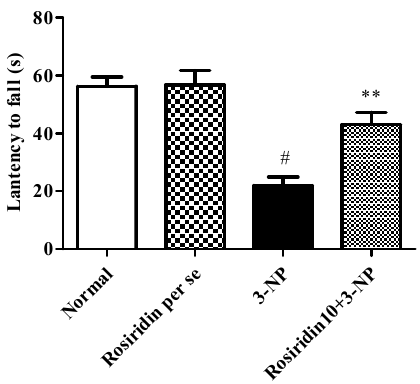
Figure 3. Effect of rosiridin on the hanging-wire test. Values are expressed as the mean ± SEM (n = 6). Values are statistically significant at p < 0.05 (one-way ANOVA followed by Dunnett’s test). Express the data ( # p < 0.05) saline vs. negative control group; (** p < 0.01) negative control group vs. treatment group.